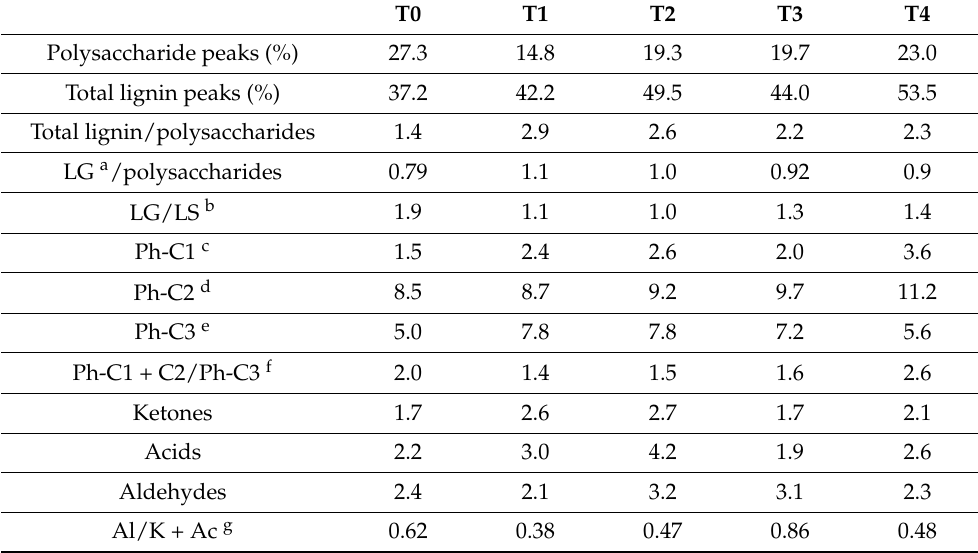
Table 2. Semiquantitative analysis of polysaccharides and lignin compounds released after Py-